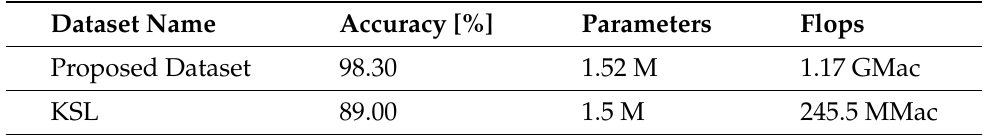
Table 1. Performance accuracy of the proposed